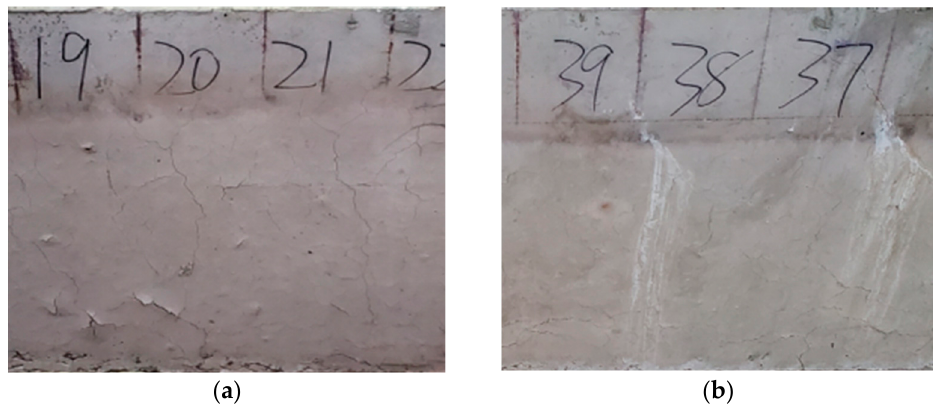
Figure 6. Water stain drawing of beam side: ( a ) ITSC beam; ( b ) NSC beam.